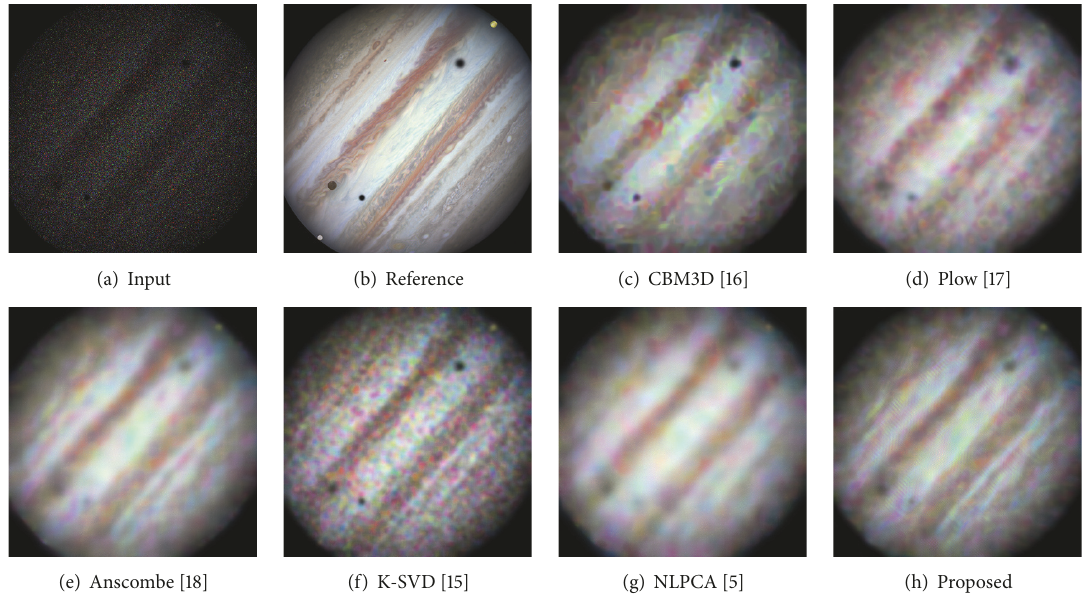
Figure 3: Jupiter: noisy input, reference, and denoised images (for peak = 1).